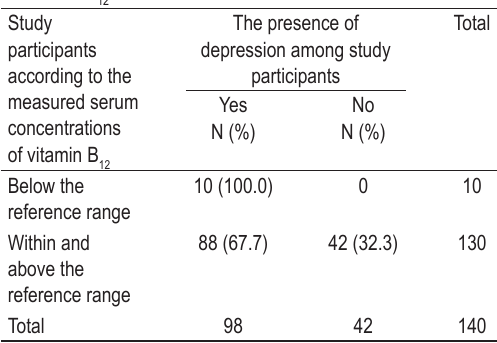
TABLE 1. The presence of depression among study participants according to the measured serum concentrations of vitamin B